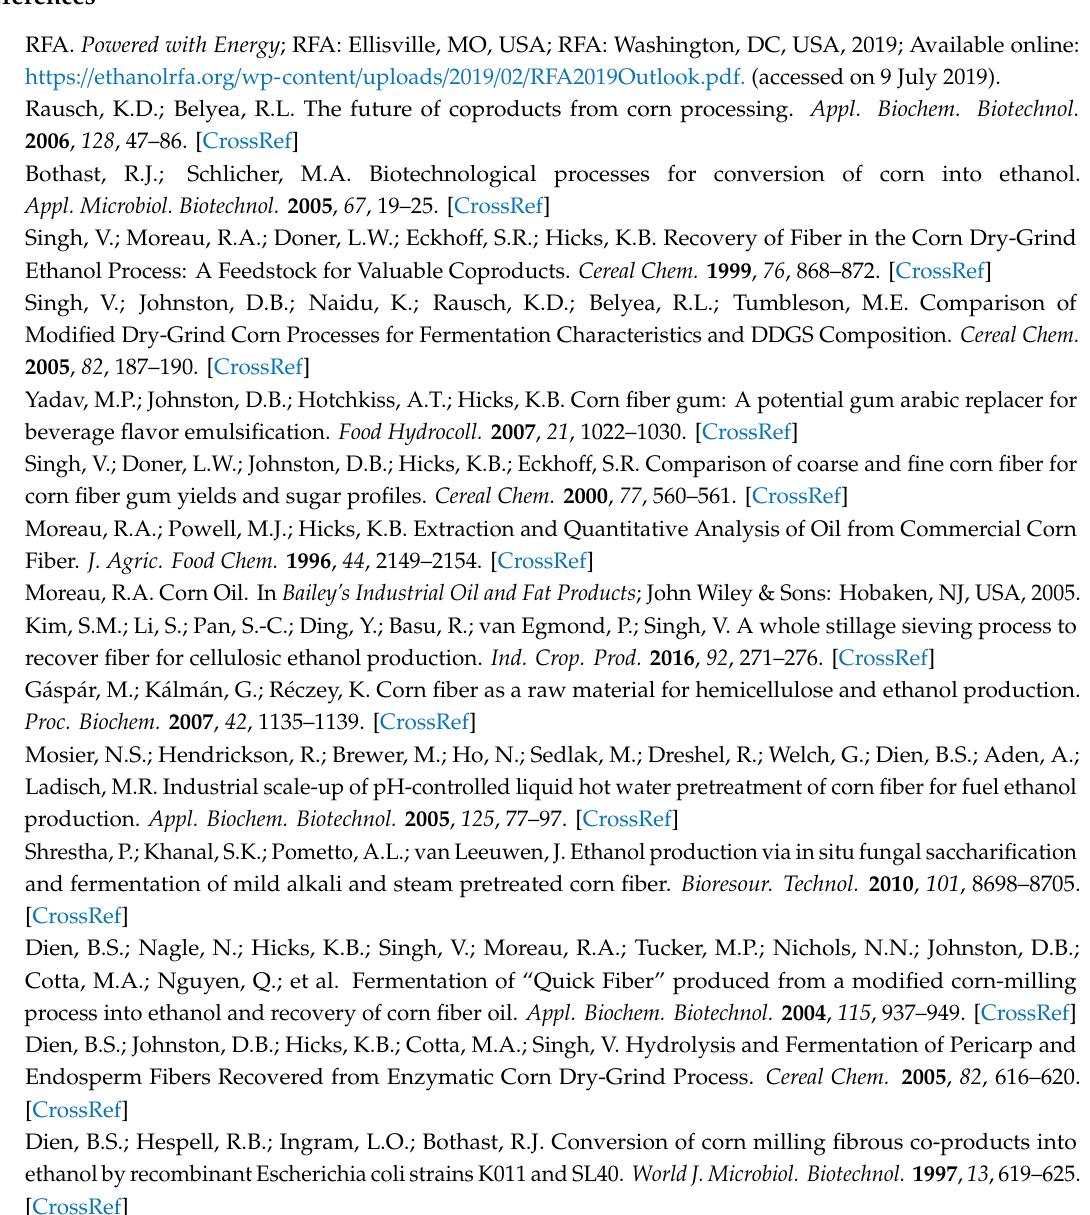
Table S1: Annual ethanol production in conventional and modified dry grind